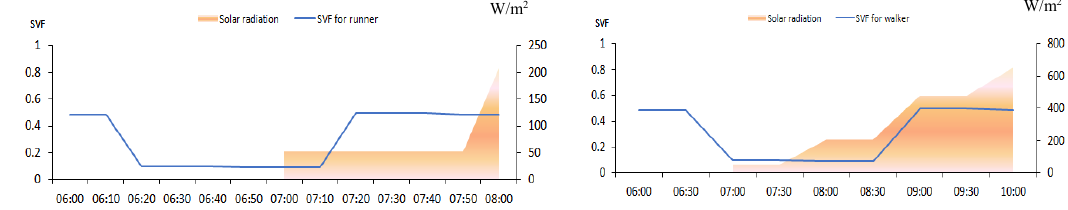
Figure 8. Autumn running event route, activity photos, and fisheye photos.